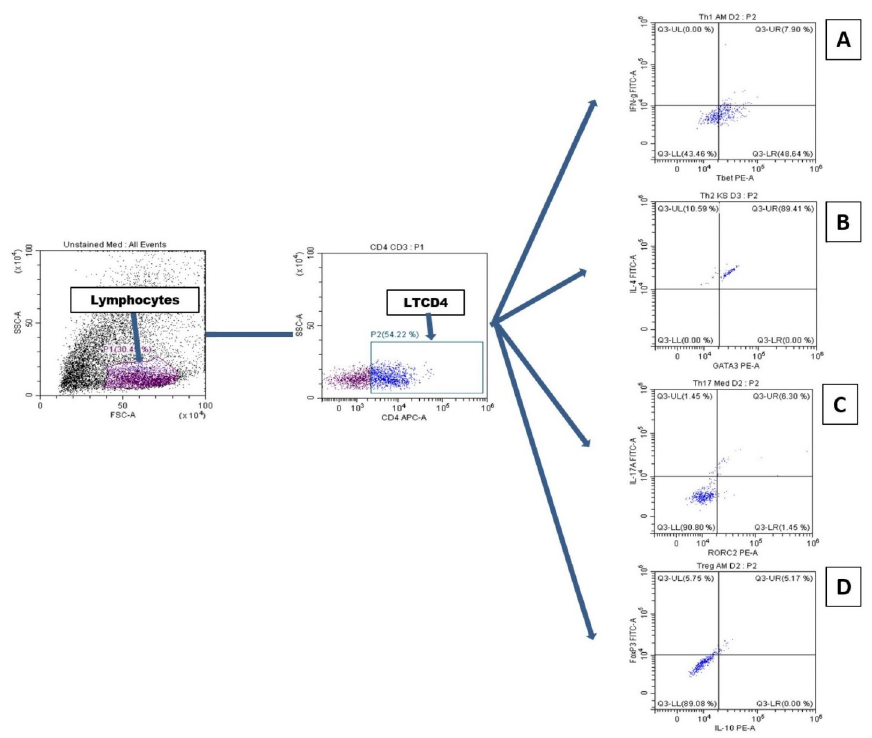
Fig 2. Gating strategy. Tbet + IFN- γ + (A), GATA3 + IL-4 + (B), RORC2 + IL-17A + (C) and Foxp3 + IL-10 + (D) cells of CD4